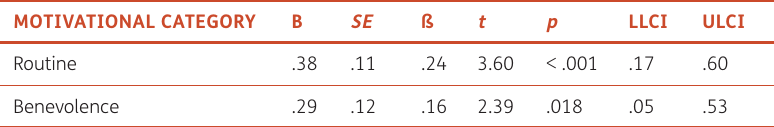
Table 3a Stepwise regression predicting participation duration in sample 1. R 2 = .117; F (2, 238) = 15.71, p < .001.